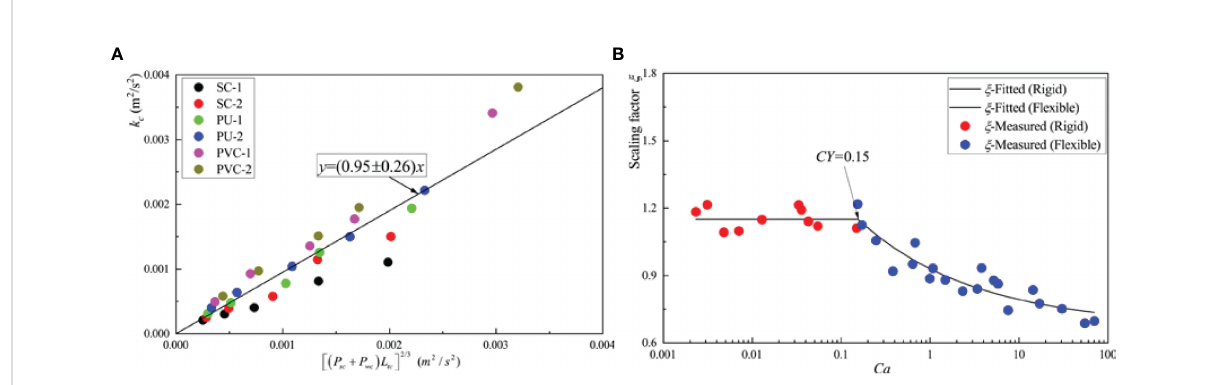
FIGURE 14 (A) Comparison between the vegetation canopy-averaged turbulent kinetic energy, k c , and [( P sc +P wc )L tc ] 2/3 . The solid black line in the fi gure characterizes the best fi t with an intercept of 0, corresponding to a scaling factor x = 0.95 ± 0.26 ( R 2 = 0.62). (B) Relationships between the